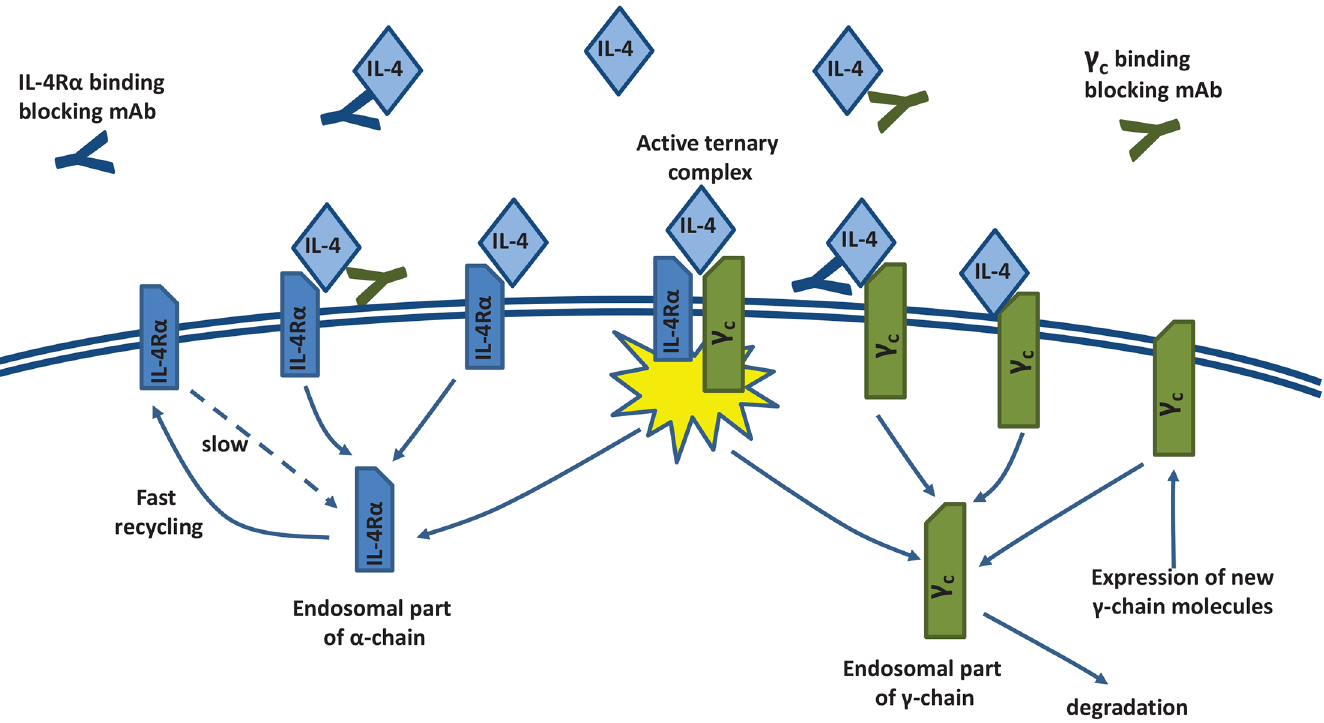
Fig 2. Cytokine-receptor model. The cytokine receptor consists of two subunits, the α -chain (IL-4R α ) and the common γ -chain (CD132). IL-4R α subunits are internalized and recycled, while common γ -chain, antibody and cytokine are degraded after internalization.